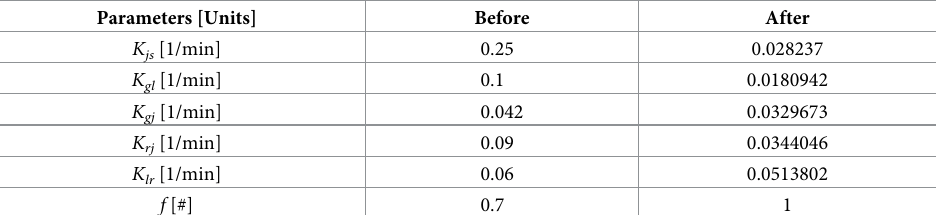
Table 2. STEP 1 results. Simo model parameters before (as reported in [40]) and after the optimization process for r data fitting. Parameters [Units] Before